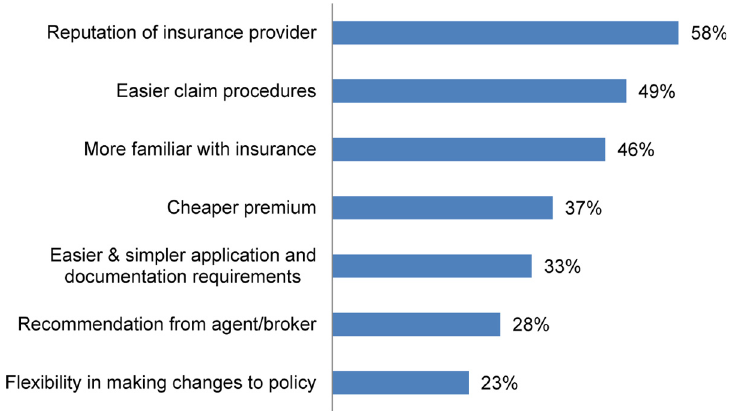
Figure 15. Ranking of factors for choosing insurance over tak (cid:1) aful